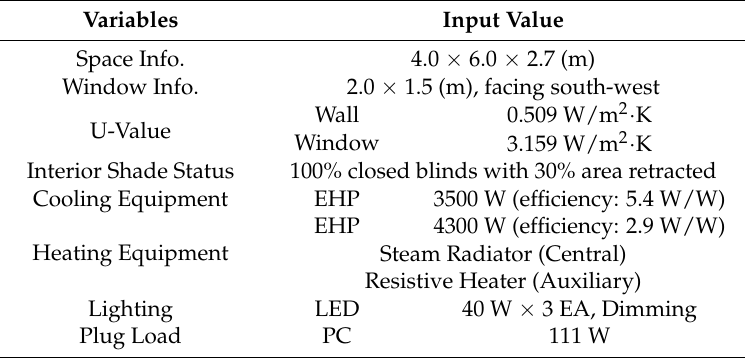
Table 11. Summary of building energy model input